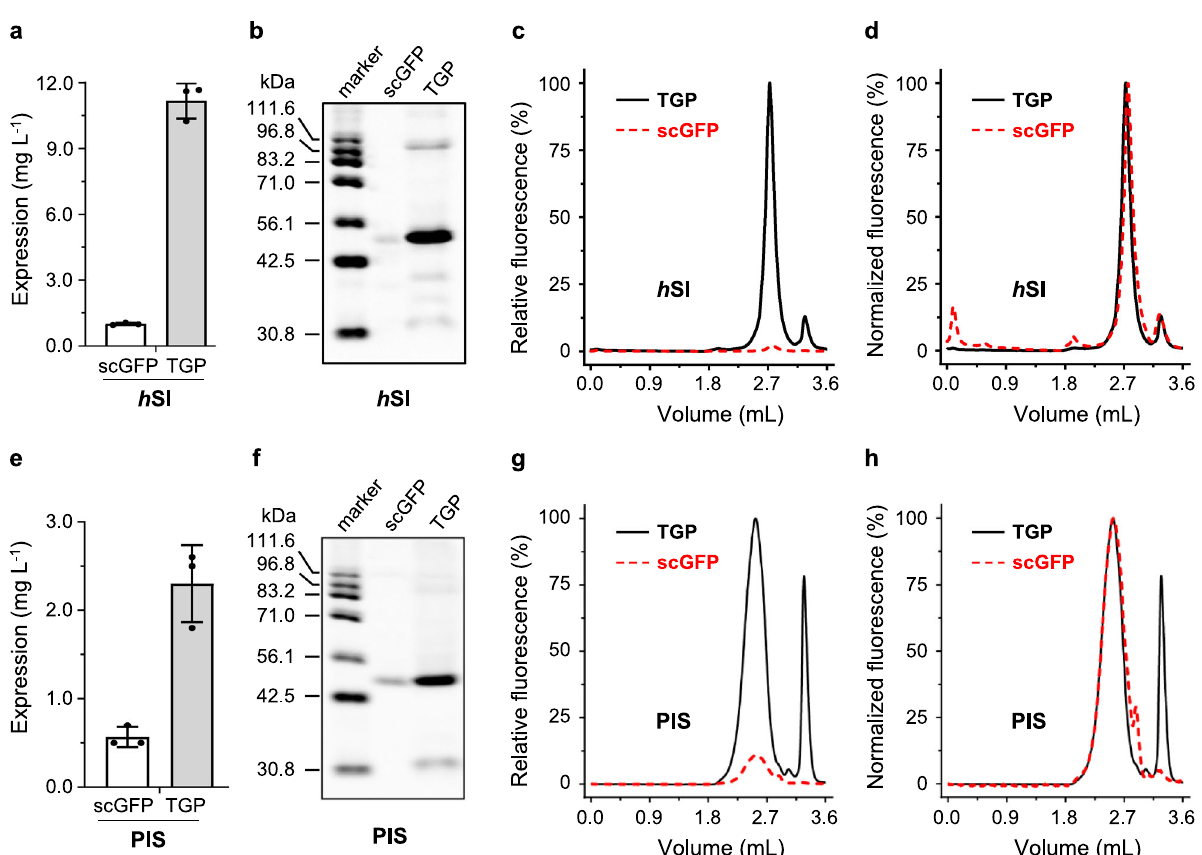
Fig. 6 Replacing GFP with TGP improved expression of two human membrane proteins in mammalian cells. Assessment of h SI expression was based on fl uorescence counts ( a ), in-gel fl uorescence ( b ), and relative FSEC intensity ( c ). Normalized FSEC traces of h SI-TGP and h SI-scGFP are shown in d . Assessment of PIS expression was based on fl uorescence counts ( e ), in-gel fl uorescence ( f ), and relative FSEC intensity ( g ). Normalized FSEC traces of PIS-TGP and PIS-scGFP are shown in h . Mean and standard deviation ( a , e ) or a representative ( b – d , f – h ) of three independent experiments on cells with different passage numbers are shown. In c , d , g , and h , TGP traces are shown as black solid lines and scGFP traces are shown as red dashed lines. FSEC fl uorescence-detection size exclusion chromatography, GFP green fl uorescent protein, TGP thermostable